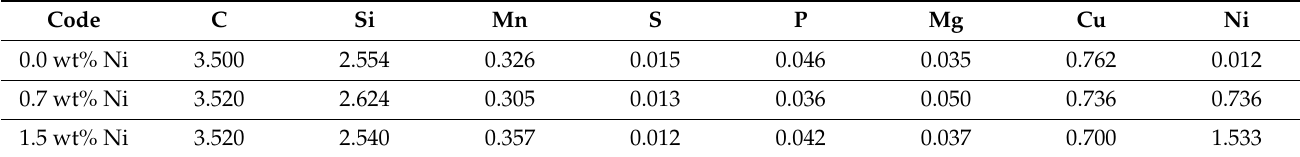
Table 1. Chemical compositions of the three ADI heats in